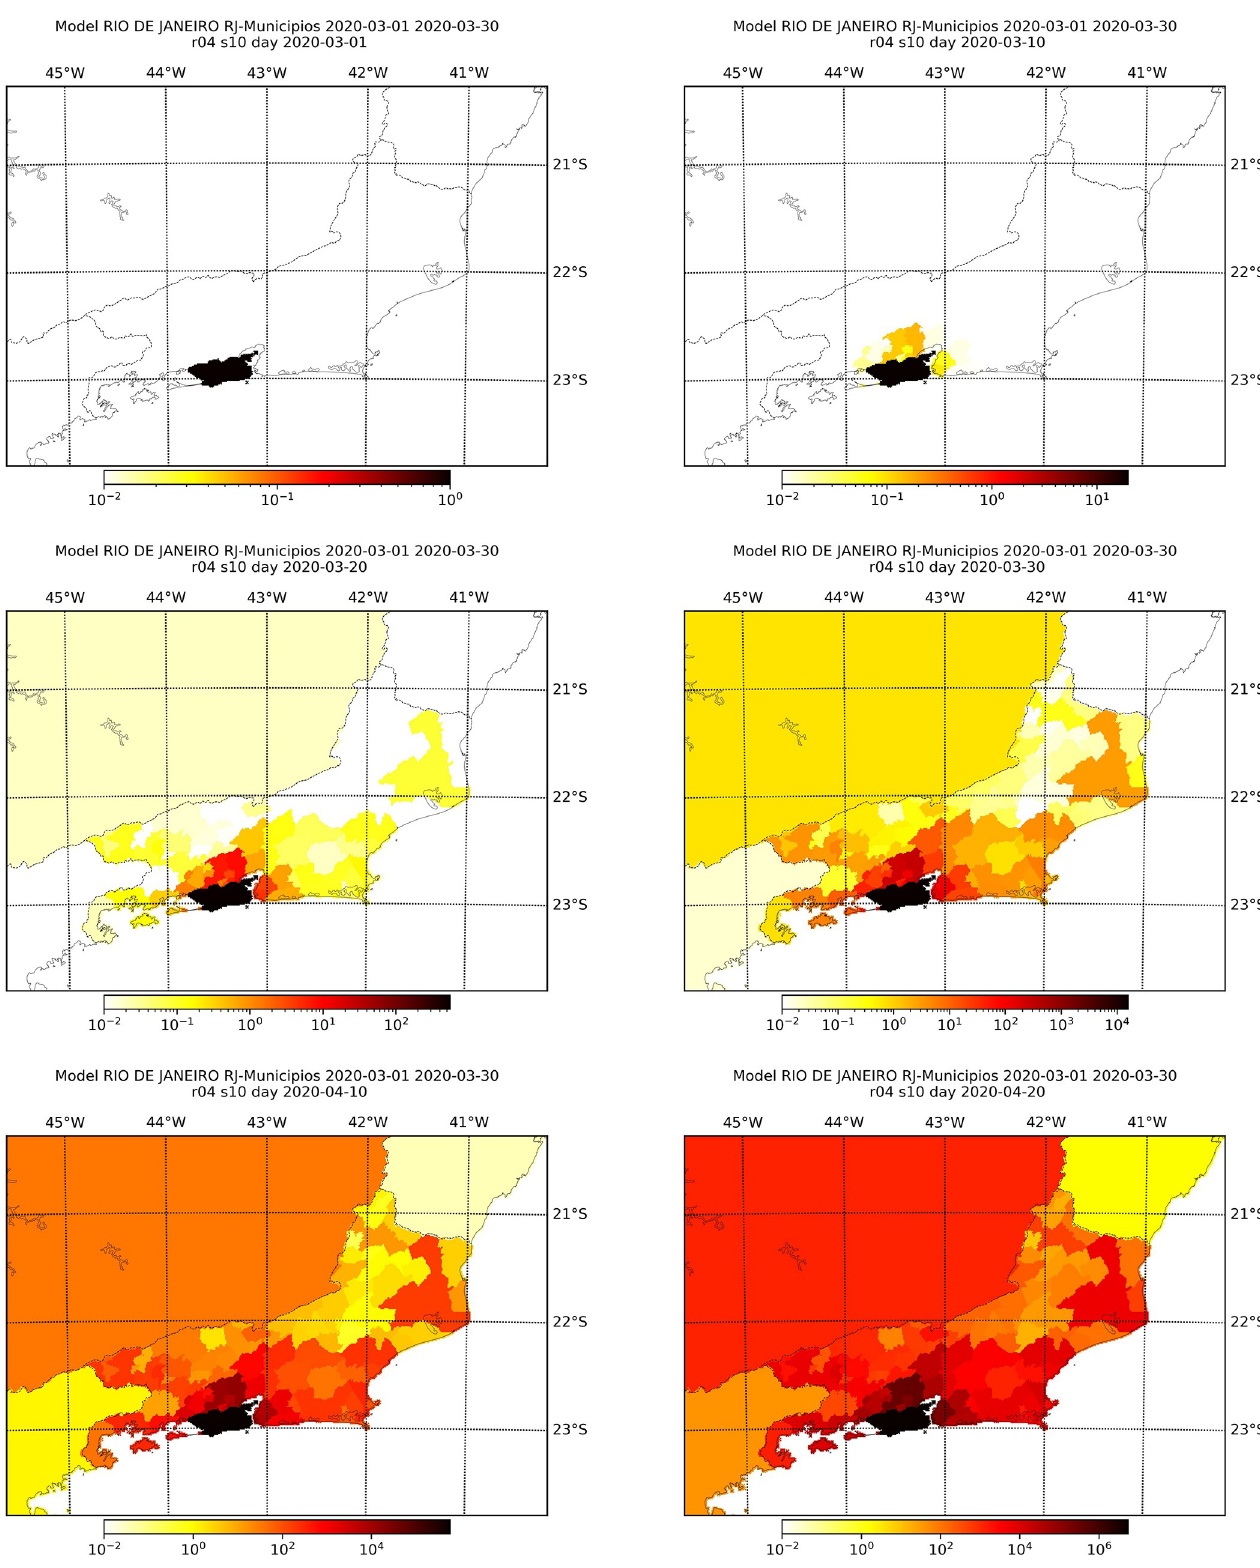
Fig 8. Simulation results for the number of infected individuals in the state of Rio de Janeiro for selected days assuming s = 1. The maps refer, respectively, to March 1 st , 10 th , 20 th and 30 th , and April 10 th and 20 th .